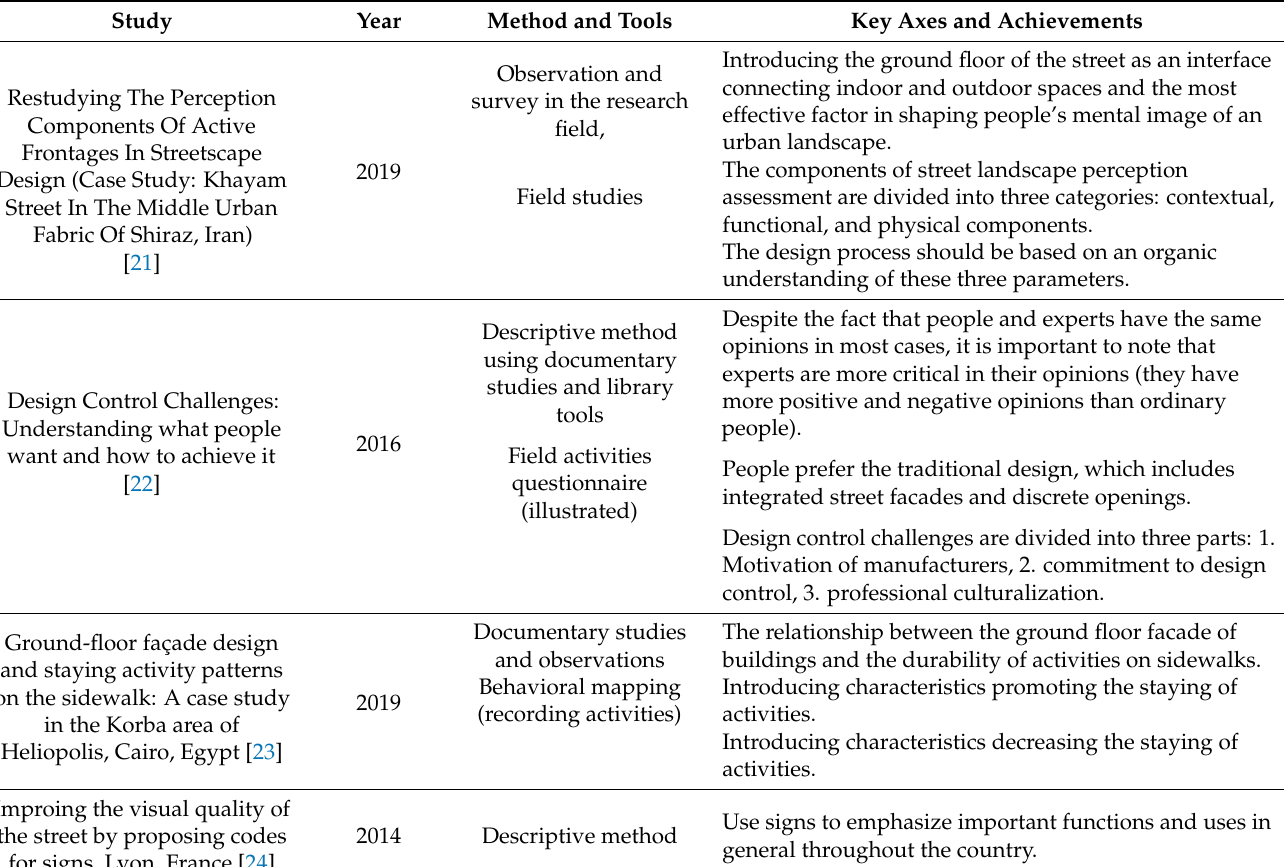
Table 1. Summary of research background review (Source: Authors,